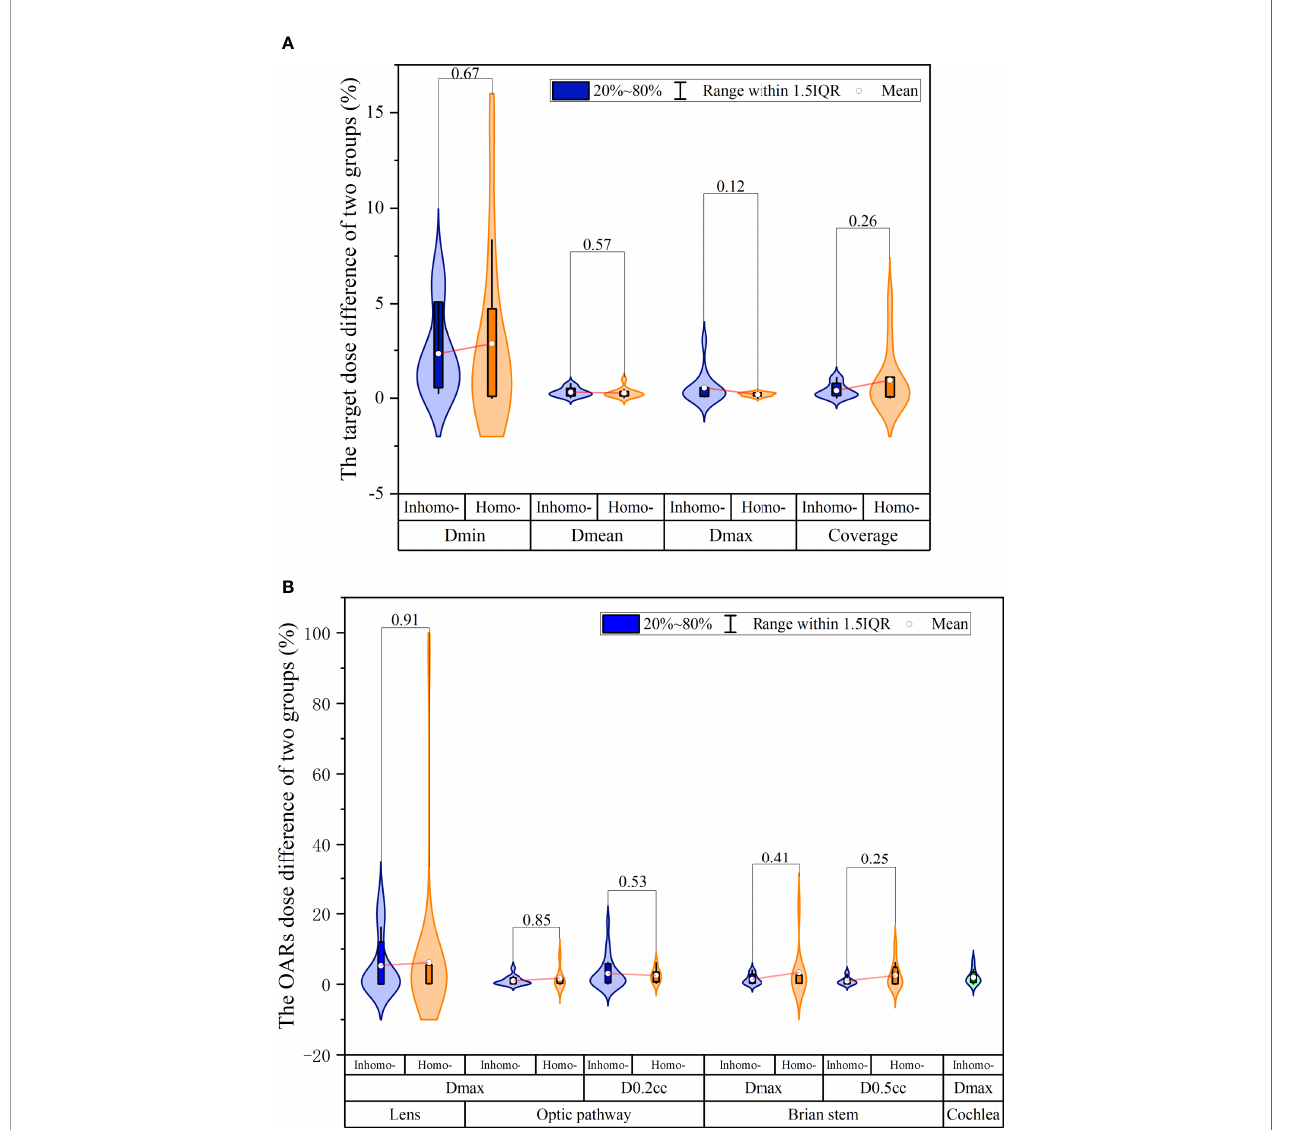
FIGURE 2 | The dosimetry and effective depth difference were extracted from the beam list log fi les. (A) The target relative dose difference of the inhomo-case vs. homo-case; it showed that the target difference value of the homo-case in minimum dose and coverage was slightly larger than that of the inhomo-case, as well as the opposite results for mean and maximum dose. (B) The OAR relative dose difference of the two cases; the values of the homo-case were larger than those of the inhomo-case, except for D 0.2 cc of the optic pathway. However, they were not statistically signi fi